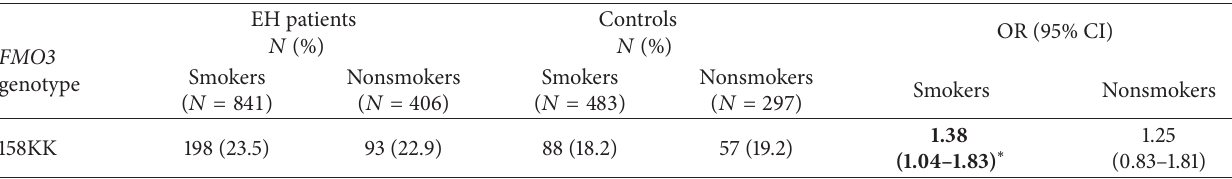
Controls 𝑁 (%) OR (95%